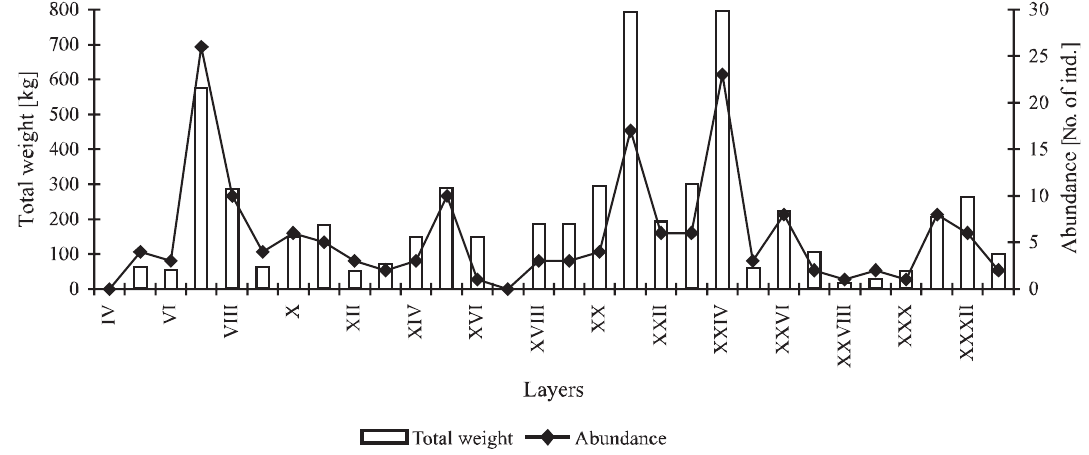
Fig. 3. Frequency of occurrence of the sturgeon, Acipenser sturio L., and its estimated total weight in the early-medieval deposit layers of the Vegetable Market (total weight in kg; abundance in number of